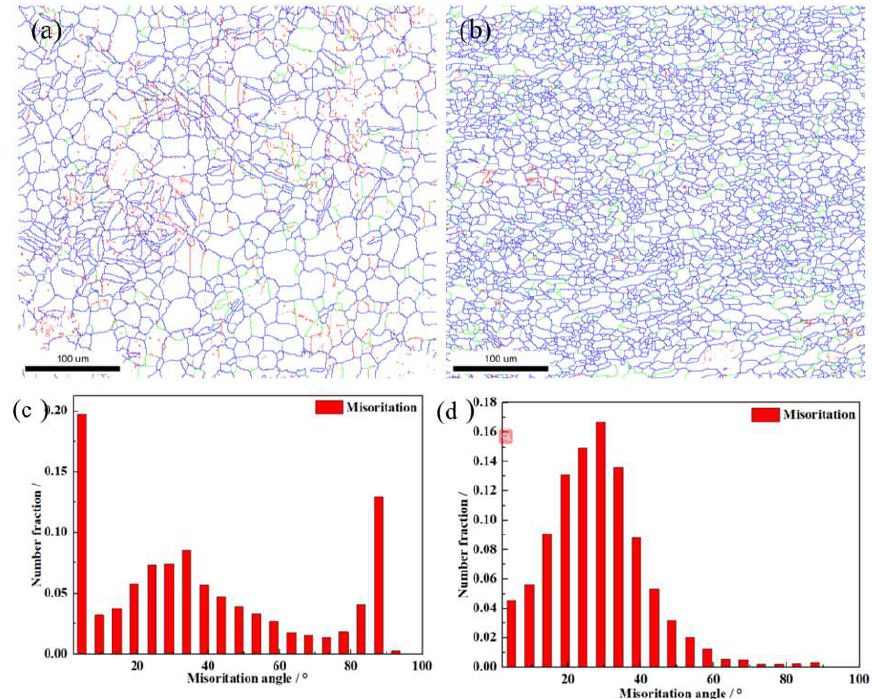
Figure 5. Grain boundary distribution and frequency of misorientation of the samples with and without the double-sided FSW process: BM: ( a ) distribution of the grain boundary; ( c ) frequency of misorientation, joint of FSW sample; ( b ) distribution of the grain boundary; ( d ) frequency of misorientation. (Red line: 2–5°; green line: 5–15°; blue line: >15°.)